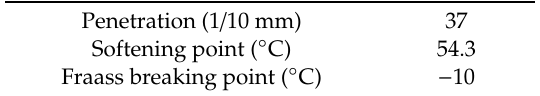
Table 1. Basic properties of the 35 / 50 penetration grade bitumen.